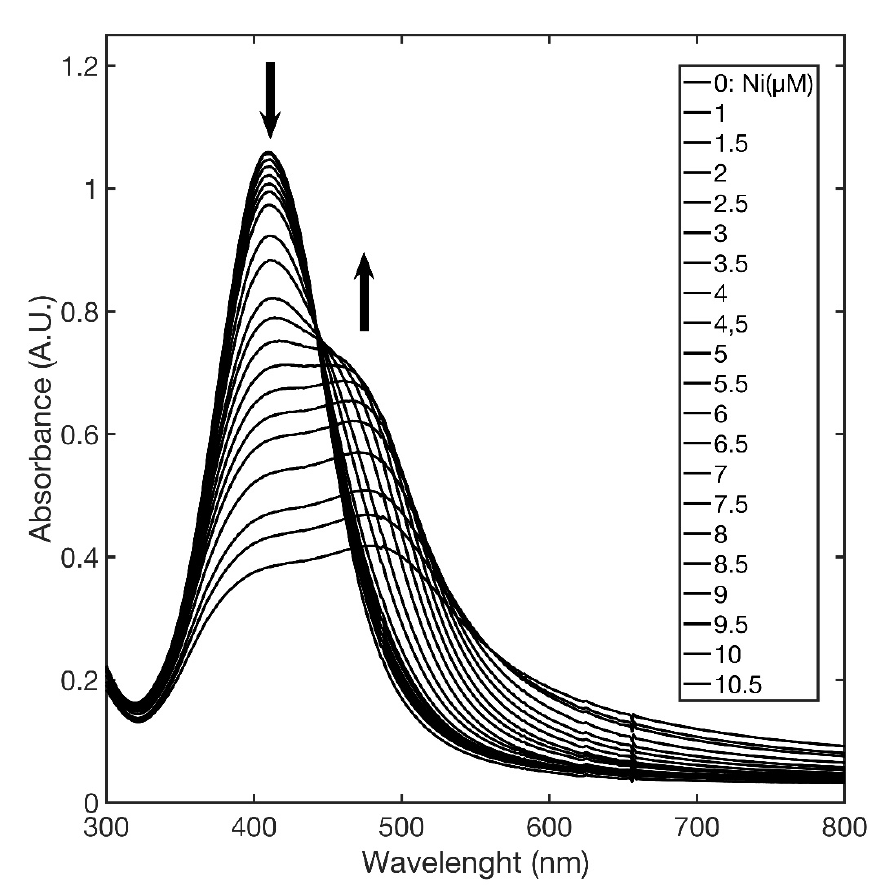
Figure 6. Changes in SPABs upon addition of increasing concentration of Ni 2+ to AgNPs@11MUA. Figure 7 shows the change in the color of the AgNPs@11MUA suspension upon titra- tion with Ni 2+ .